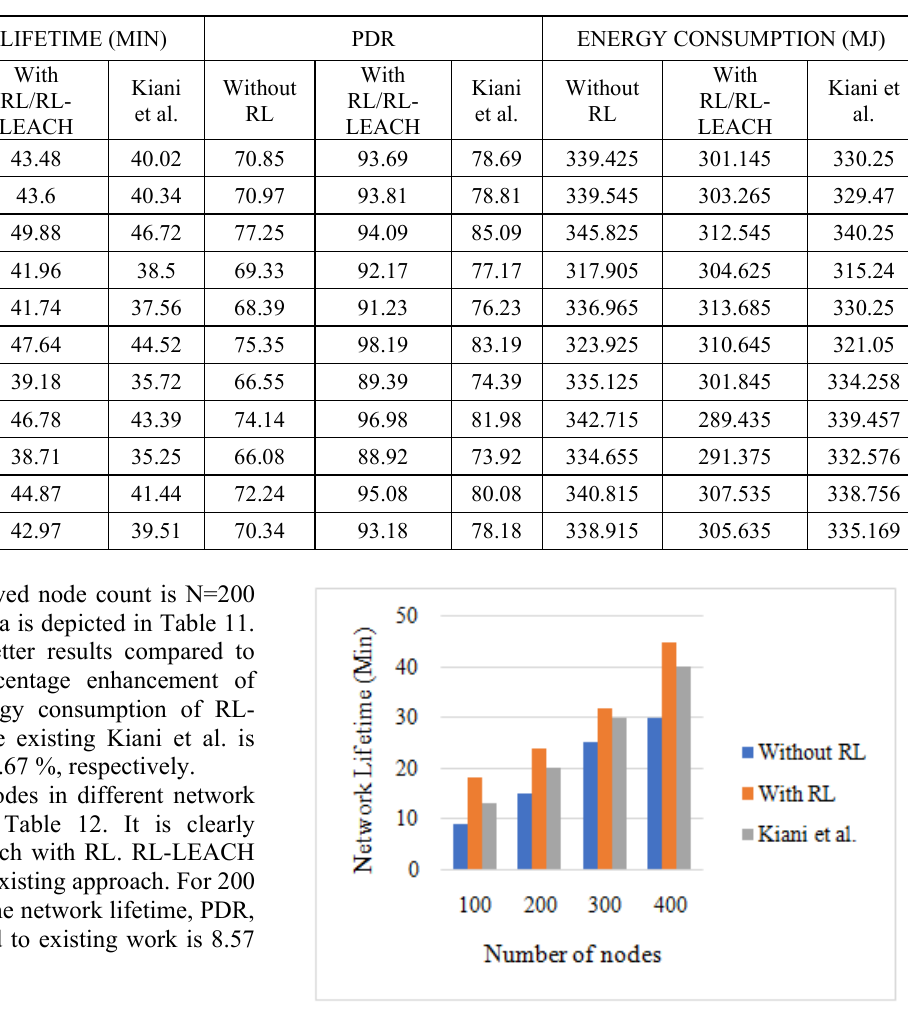
Figure 15. Network Lifetime (min) The computed values of network lifetime for different number of nodes deployed in with various network size as depicted in Figure 15. From the figure it is clearly seen that with the increase in the number of nodes the network life increases. The comparative graph consists of three types of bar represented by the blue, the orange and the grey colour depicting the values of network life for without RL, with RL and Kiani et al. Among all, the proposed approach provides better network life. With the increase in the number of nodes (N), the rate of receiving data packet increases with the reduction of data packet transmission rate. This is due to the affecting nodes properties like as hop count, nodes failure, nodes